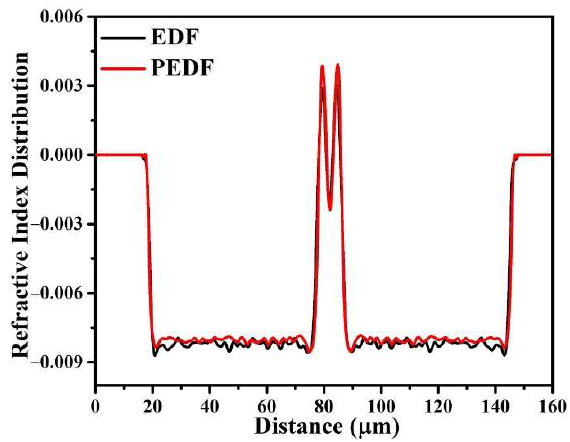
Figure 7. The refractive index difference distribution of EDF and PEDF.